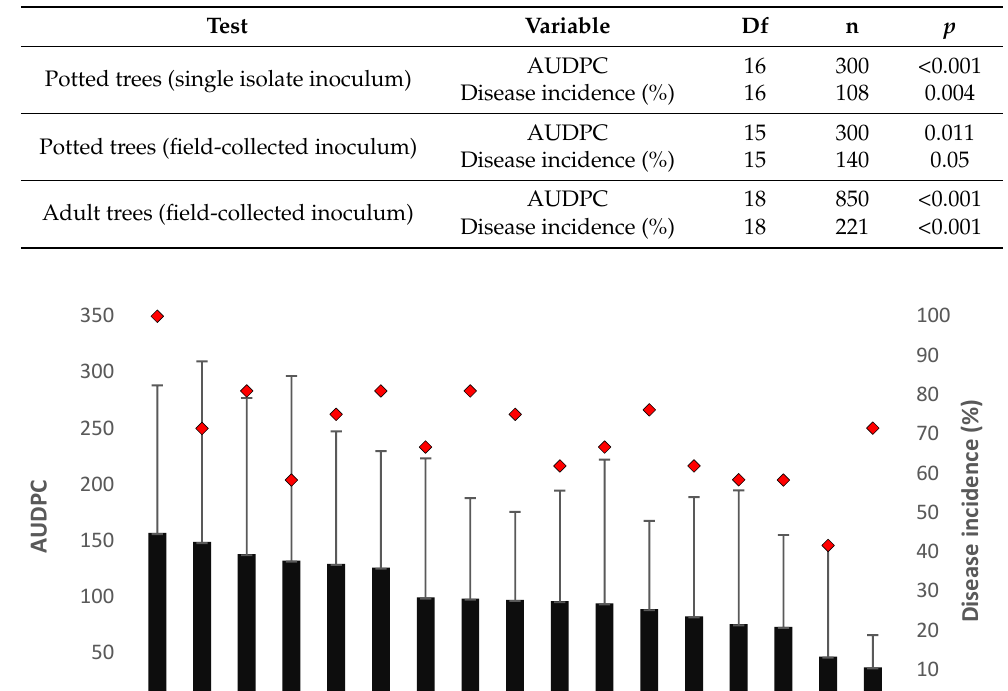
Figure 1. Mean area under disease progress curve (AUDPC; mean ± SD) and disease incidence (pro- Table 3. Results of generalized linear models (GLM) analyses for AUDPC and disease incidence portion of infected wounds as a percentage of the number of inoculated wounds) for detached (%) in three artificial inoculation tests. Degrees of freedom (Df) stands for the number of accessions shoots inoculated with a single N. ditissima isolate calculated 42 days post-inoculation. The solid black bars represent AUDPC values whereas the red rhombuses indicate the disease incidence per- evaluated in each experiment. The letter “n “stands for the number of inoculation points for the centage. AUPDC analysis and the number of inoculated shoots (adult trees test) or potted trees in the disease incidence (%) analysis.